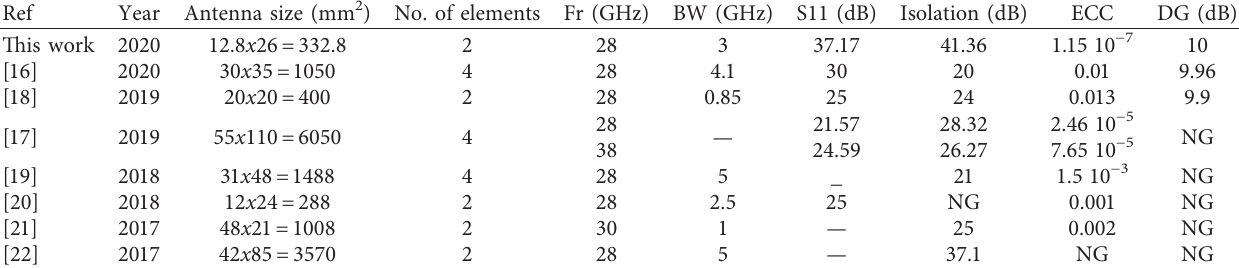
Table 4: Performance comparisons of the proposed MIMO antenna with recently published works.